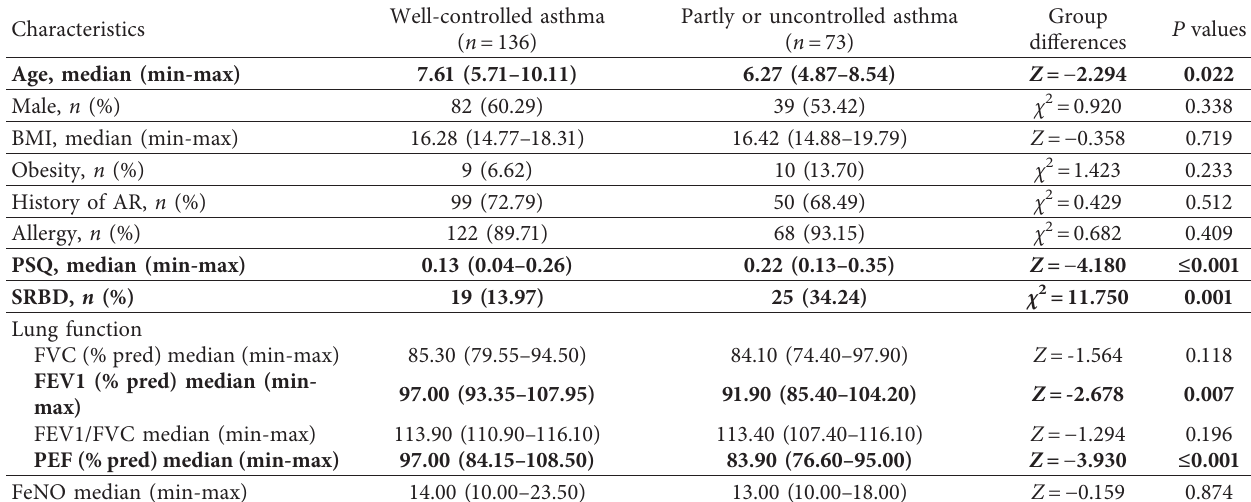
Table 1: General characteristics of enrolled children according to asthma control